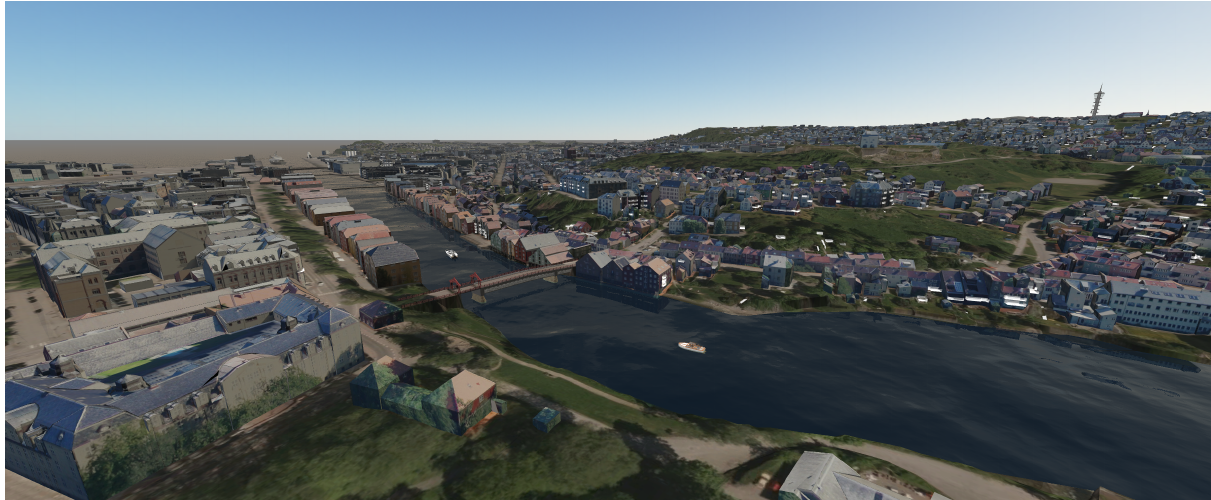
Figure 4: 3-D visualization of two AIS detected ships moving down the Nidelven river in Trondheim using the Unity game engine (Unity, 2018).